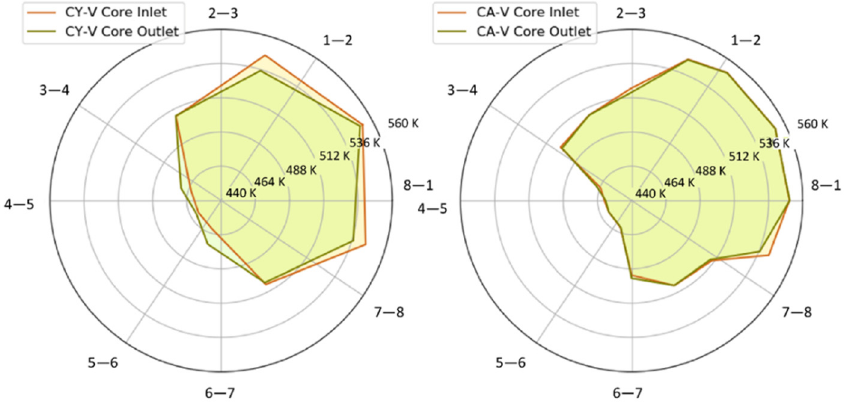
Figure 26. The coolant temperature profile at the core inlet and outlet of the AP1000 CY-V and CA-V (data from the CY-V_sectors and indexed CA-V_cells in Figure 21).